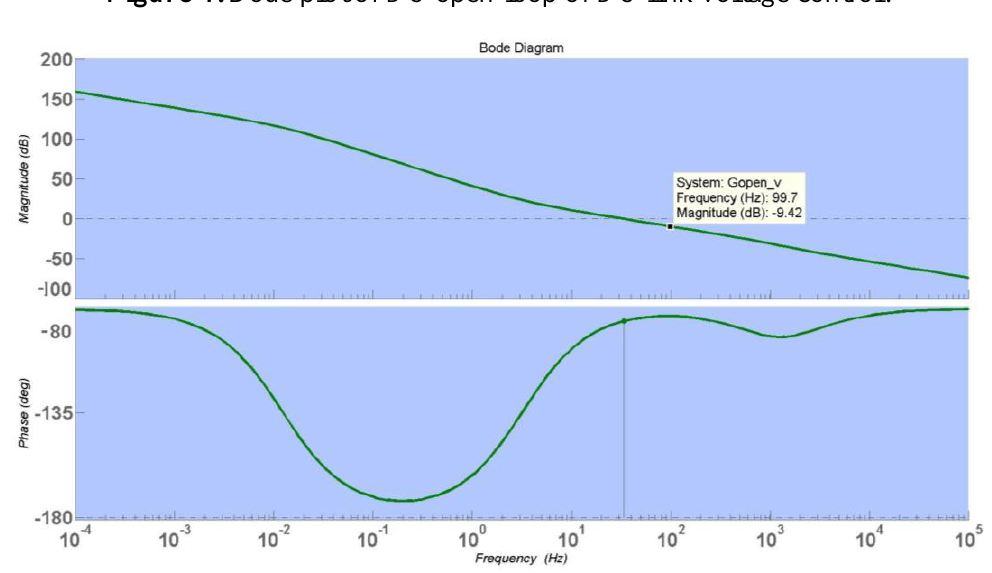
Figure 4. Bode plot of DC open-loop of DC link voltage